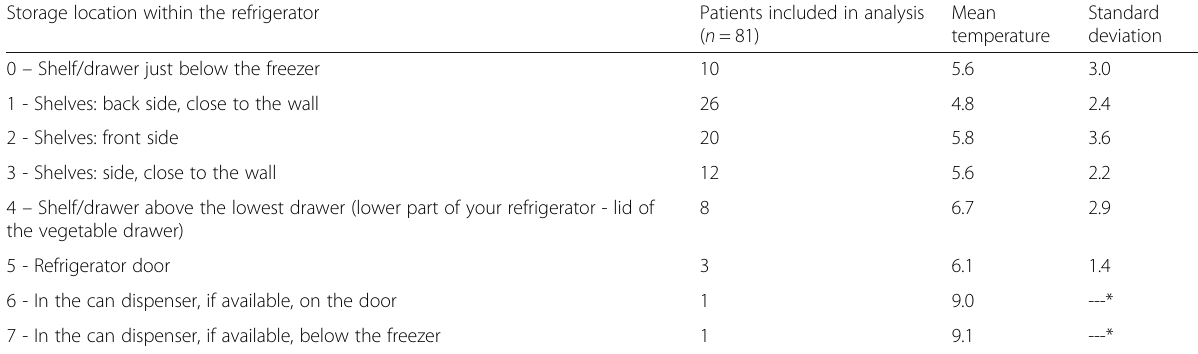
Table 5 Mean temperature by subgroups of storage location within the refrigerator Storage location within the